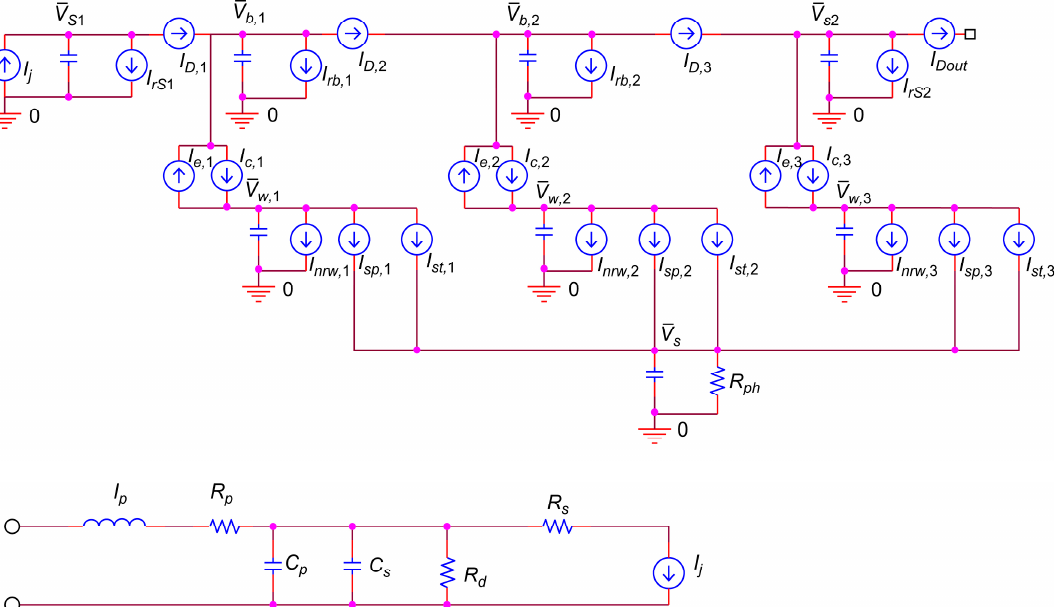
Figure 2. Equivalent circuit model of a multiquantum-well laser (considering 3 quantum wells as an example).